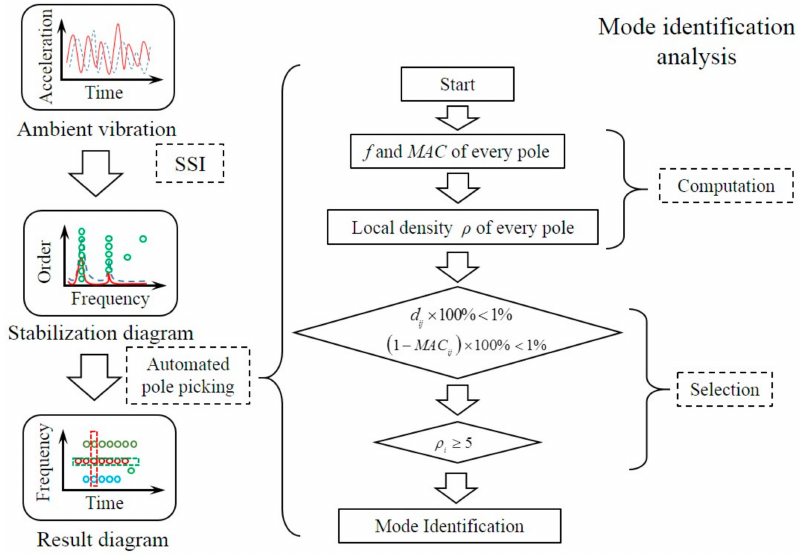
Figure 12. Flow chart of the proposed pole-picking